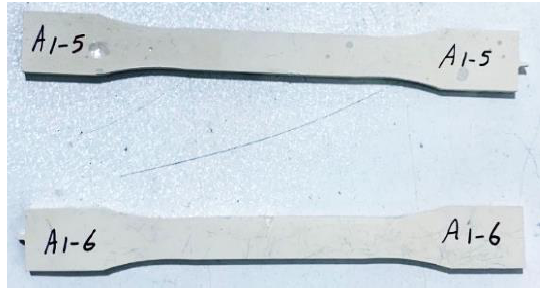
Fig. 6. Samples tested in